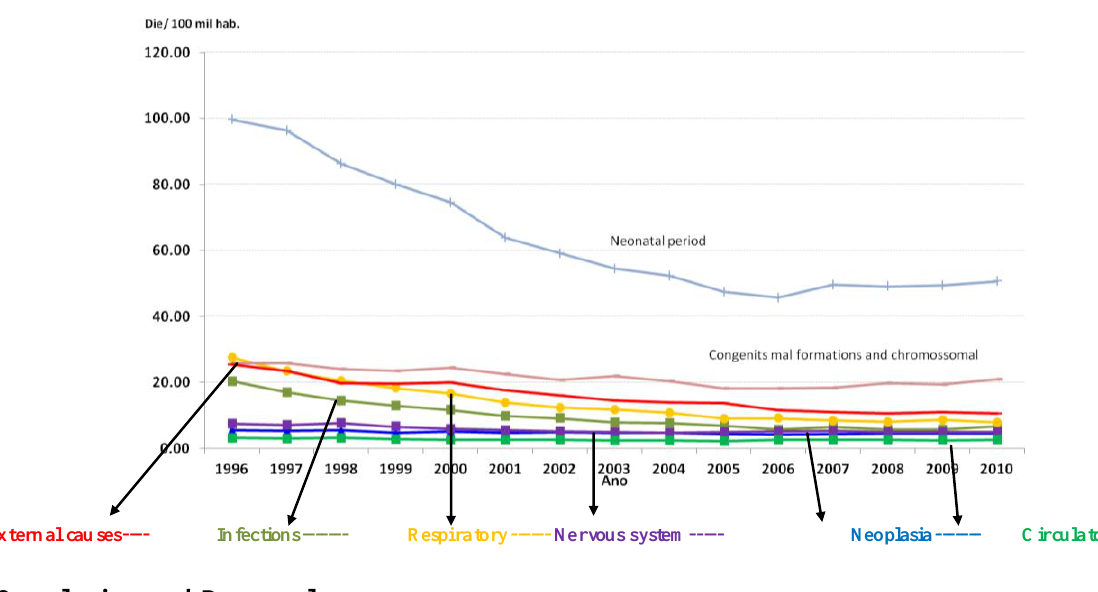
Figure 14. Causes of child mortality in Brazil